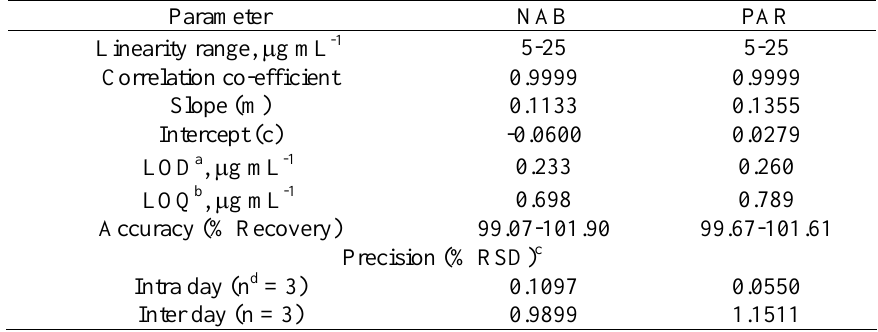
Table 3. Summary of validation parameters of proposed RP-HPLC method Parameter